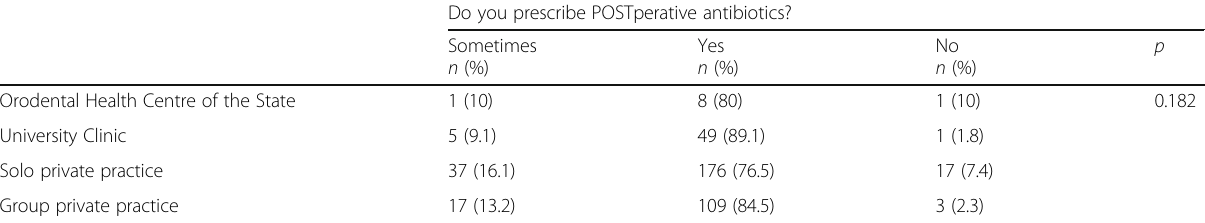
Table 11 Postoperative antibiotic prescribing habit by practice type Do you prescribe POSTperative antibiotics?